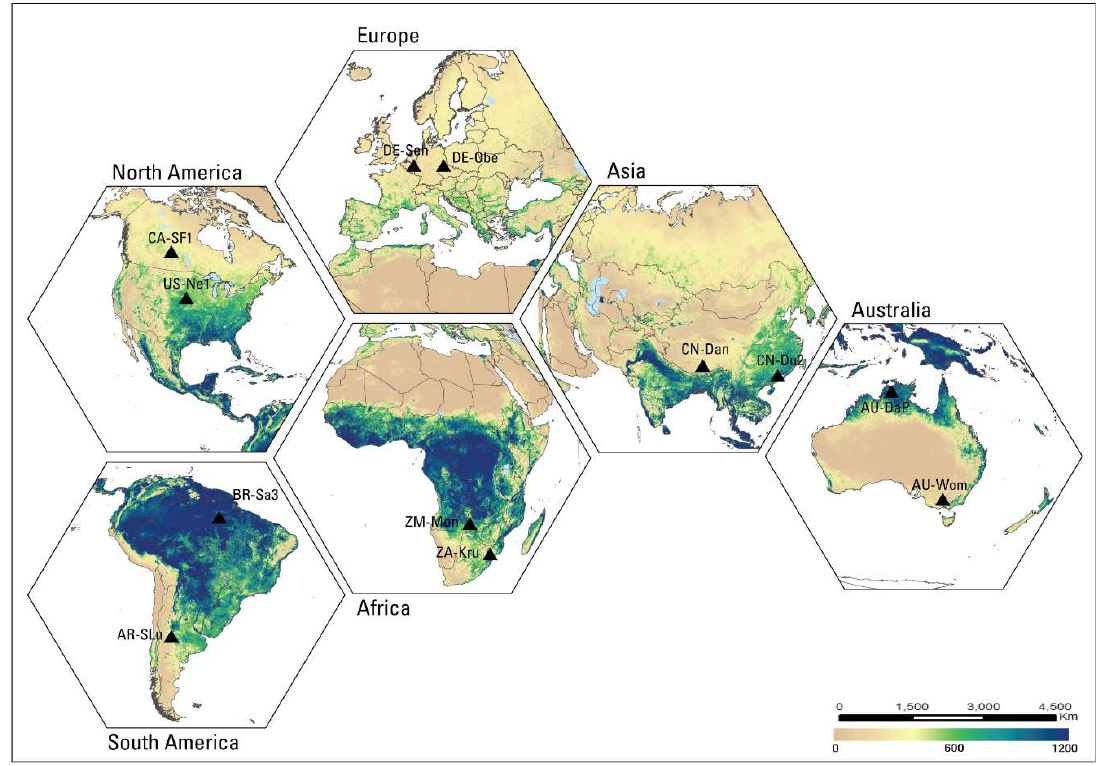
Figure 3. 2018 annual ETa map (mm) with 12 flux tower locations. There are two sites on each of the six continents.